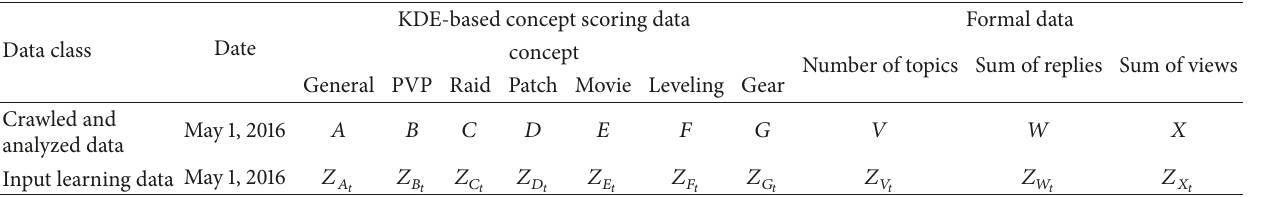
Table 2: Example of a machine learning data set.